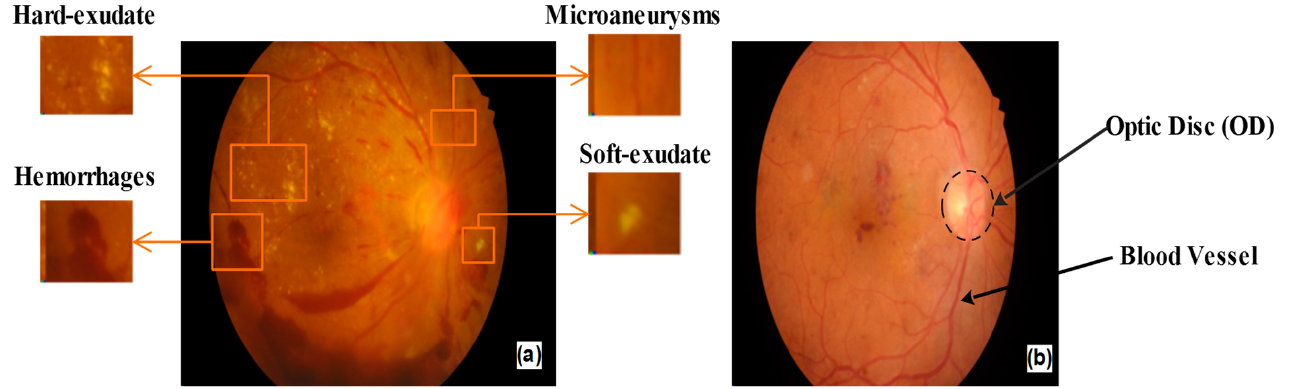
Figure 1. ( a ) NPDR lesions, ( b ) optic disc and blood vessel [10]